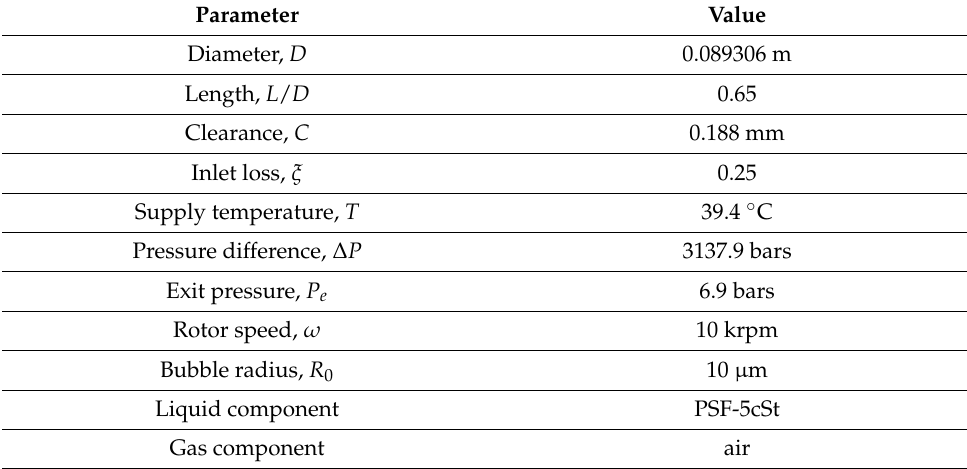
Table 1. Seal geometrical parameters and operational conditions